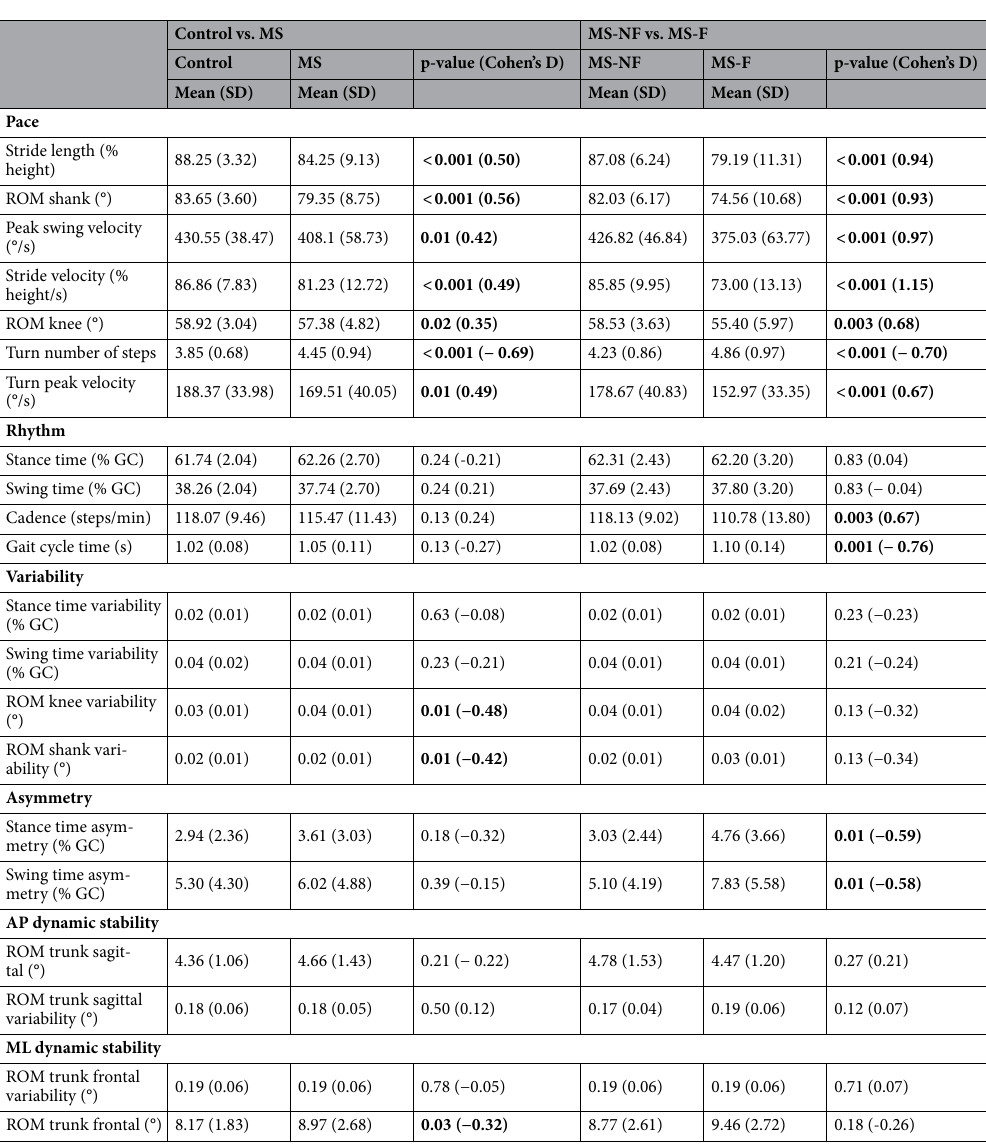
Table 1. Mean and standard deviation (SD) of gait parameters in Controls, MS (all), and MS faller and non- faller subgroups. MS multiple sclerosis, MS-NF people with MS that reported no falls in the last 6 months, MS-F people with MS that reported one or more falls in the previous 6 months, % GC percent of the gait cycle. Variability was computed using the coefficient of variation. Bold indicates significance at the p < 0.05 level.